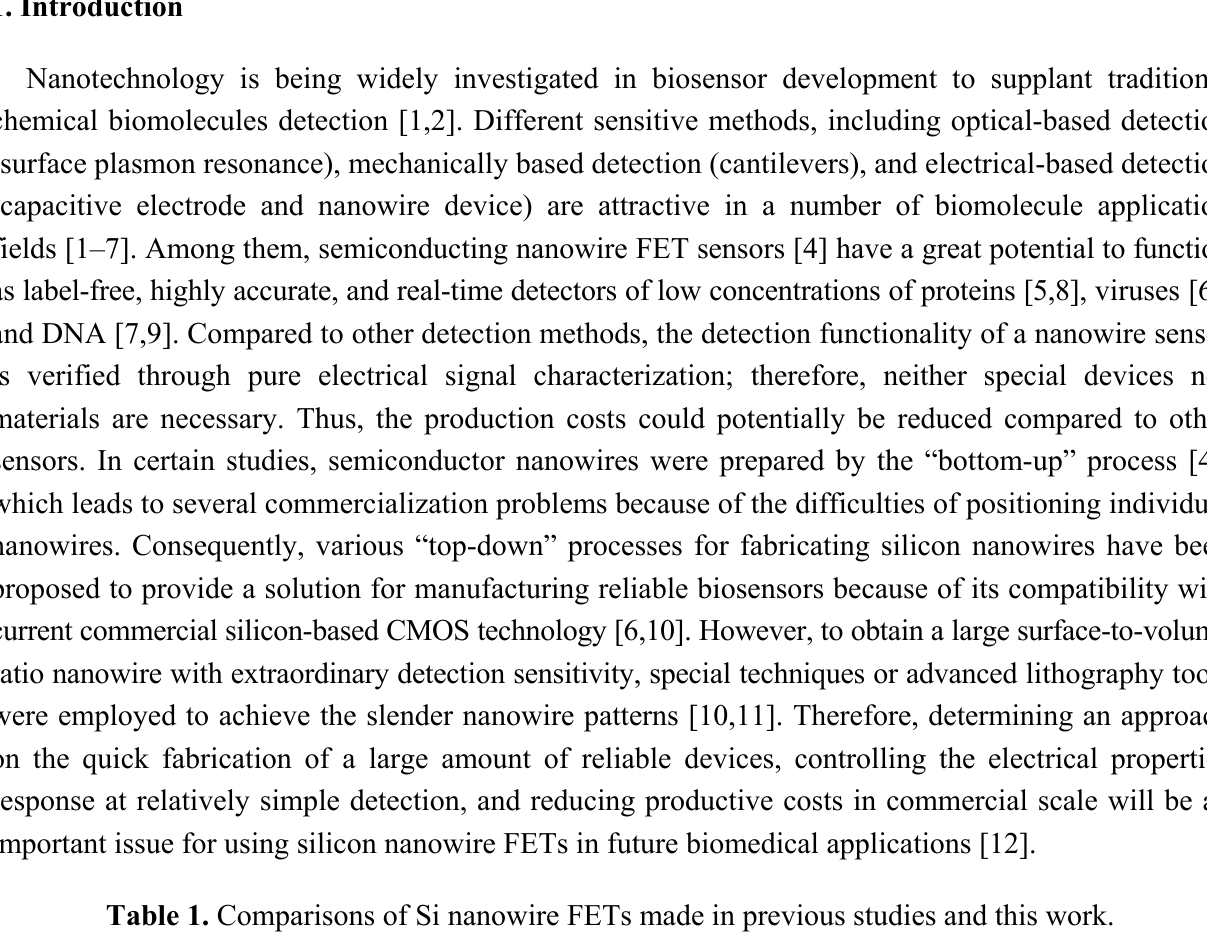
Table 1. Comparisons of Si nanowire FETs made in previous studies and this work. Ref. NW